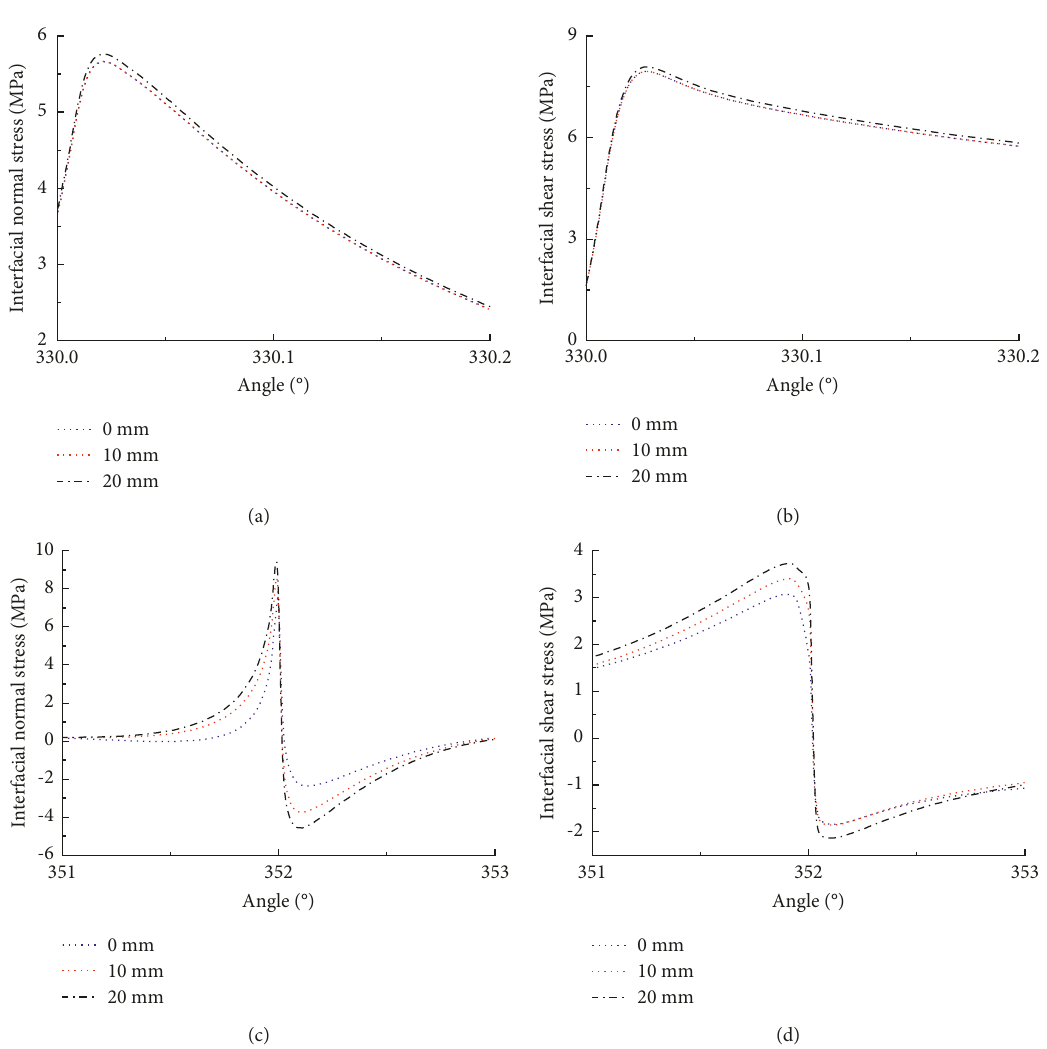
Figure 12: Interfacial stresses under different pre-deformations. (a) Normal stress near plate end. (b) Shear stress near plate end. (c) Normal stress near 352 ° joint. (d) Shear stress near 352 °